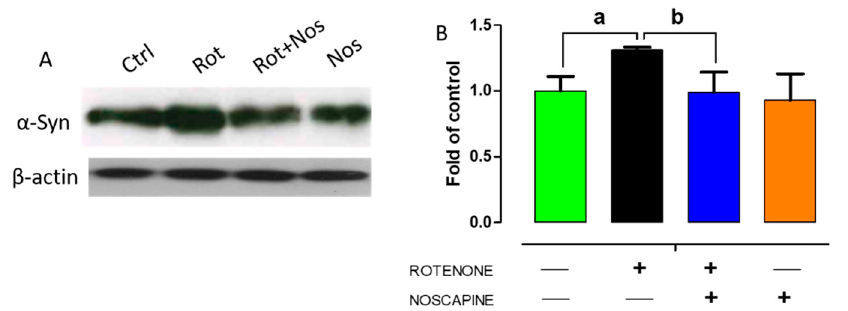
Figure 5. Noscapine modulates the expression of α -synuclein in rotenone-treated animals. Represen- tative immunoblots of alpha-synuclein expression in experimental animals ( n = 5) ( A ). Image J was used for quantitative analysis ( B ). Data are expressed as mean ± SEM. a p < 0.05 compared to control, b p < 0.05 compared to rotenone-treated